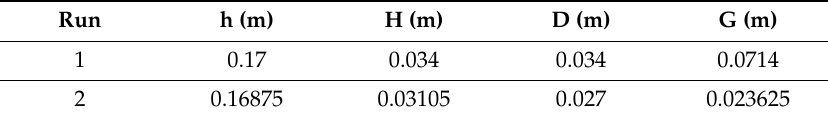
Table 1. Parameters of selected experimental runs.